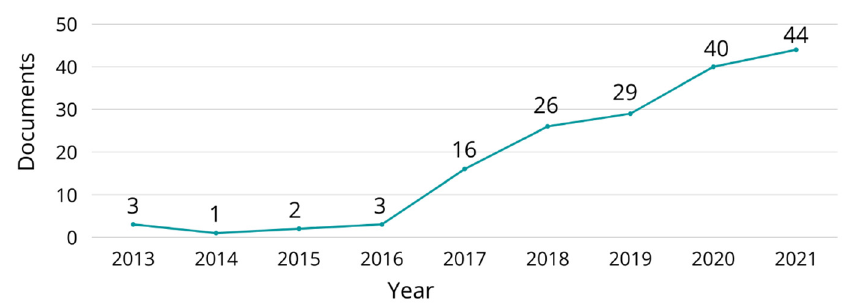
Figure 11. Temporal distribution of the studies where recycled plastics was evaluated as possible feedstock in FDM until 2021.